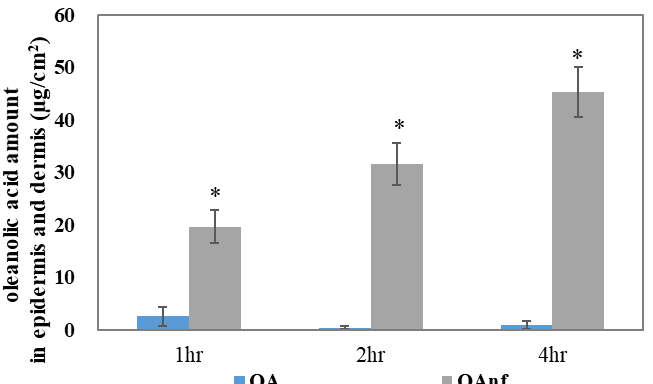
Figure 7. In vitro skin penetration of raw OA and OAnf in ex vivo pig skin. The amount of OA in the epidermis and dermis at various time points was determined. Results are shown as mean ± SD ( n = 5). * p < 0.05 significance with raw OA.